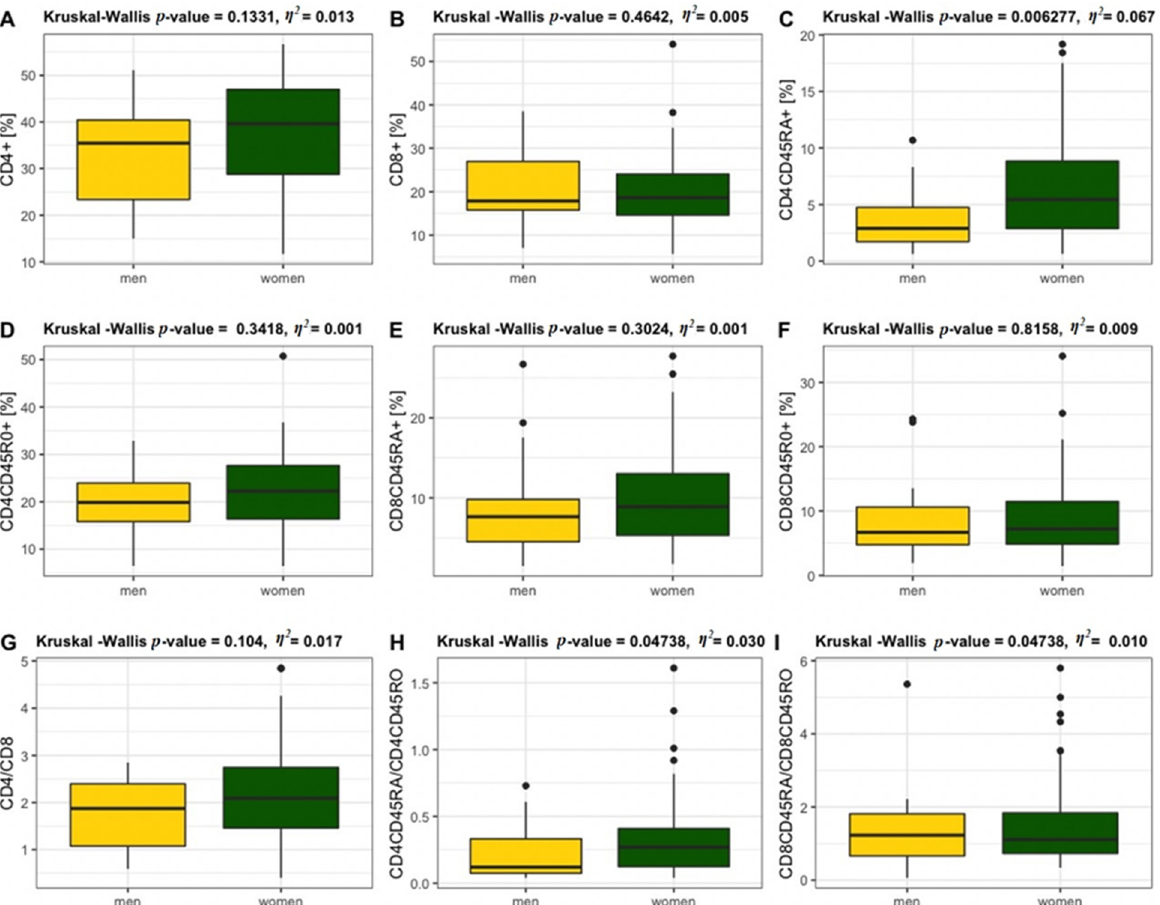
Figure 5. Percentages of total CD4 + ( A ) and CD8 + ( B ) T lymphocytes and the CD4 + naïve ( C ) and CD4 + memory ( D ) and CD8 + naïve ( E ) and CD8 + memory ( F ) T lymphocyte in older women ( n = 83) and men ( n = 16) and the following ratios: CD4/CD8 ( G ), CD4CD45RA/CD4CD45RO ( H ) and CD8CD45RA/CD8CD45RO ( I ).